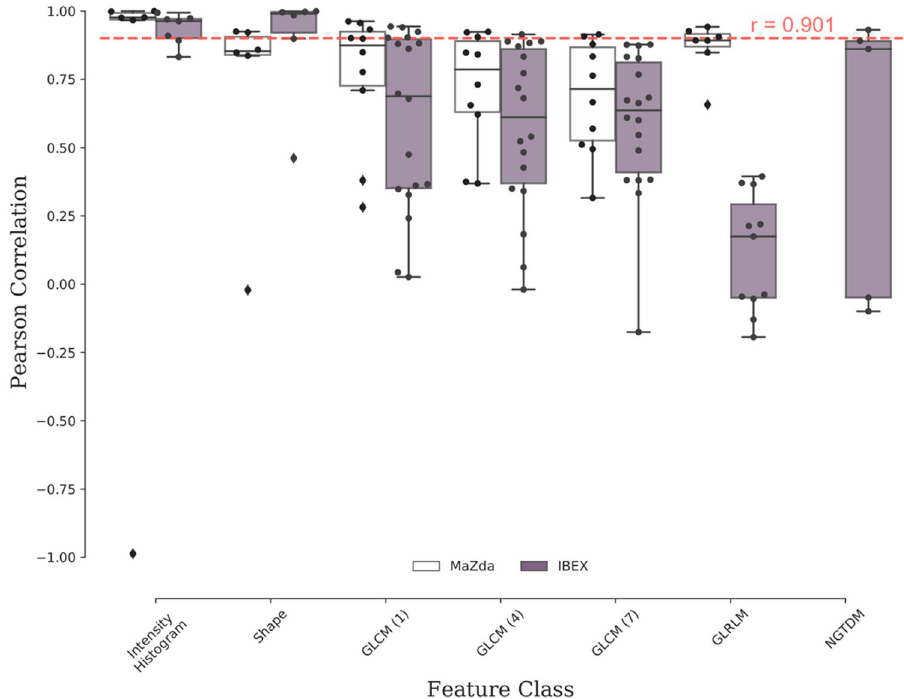
Figure 3. Summary of linear correlation of apparent diffusion coefficient (ADC) radiomic features between PyRadiomics and (white) MaZda and (purple) IBEX software. The reproducibility threshold (red-dashed line) is defined as greater than a Pearson correlation coefficient of 0.901. This analysis identified a sub- set of reproducible features between IBEX and PyRadiomics from intensity histogram (5/7), shape (4/6), GLCM (neighbourhood 1:4/18, 4:1/18, 7:0/18), GLRLM (0/11) and NGTDM (1/5) categories. The sub-set of reproducible features between MaZda and PyRadiomics is intensity histogram (5/6), shape (2/6), GLCM (neighbourhood 1:3/10, 3:4/10, 7:2/10), GLRLM